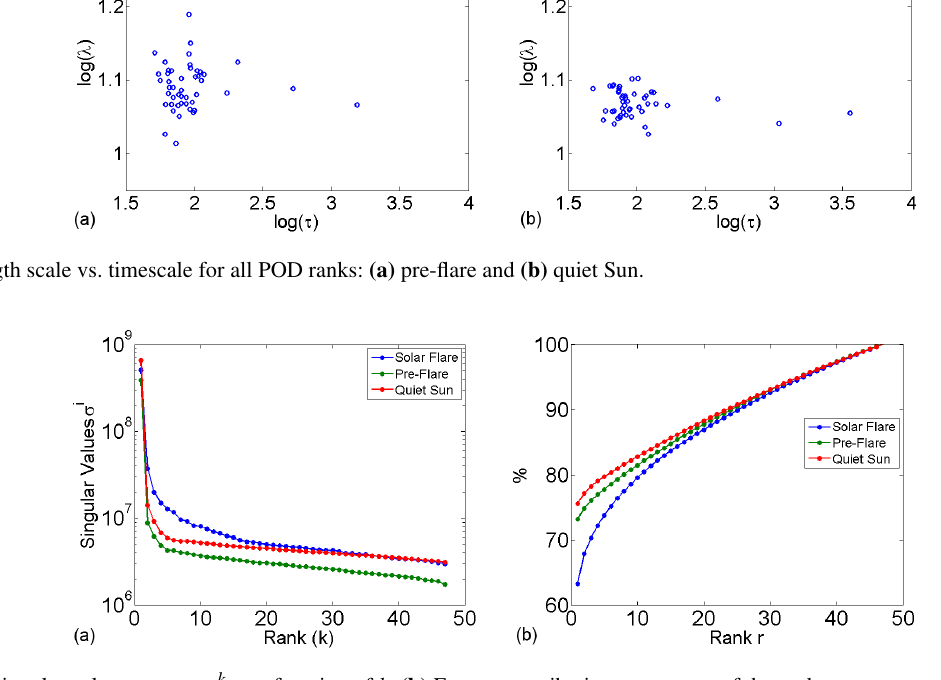
Figure 9. (a) Singular values spectra σ k as a function of k . (b) Energy contribution percentage of the rank- r